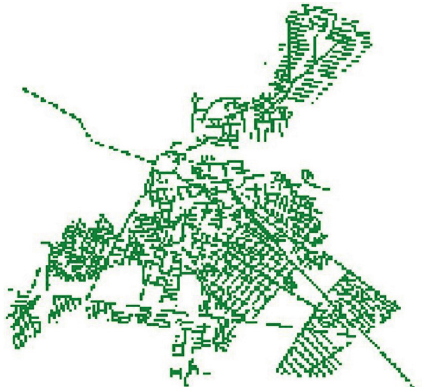
Figure 26: The total number of damage under PGA10% according to the VI